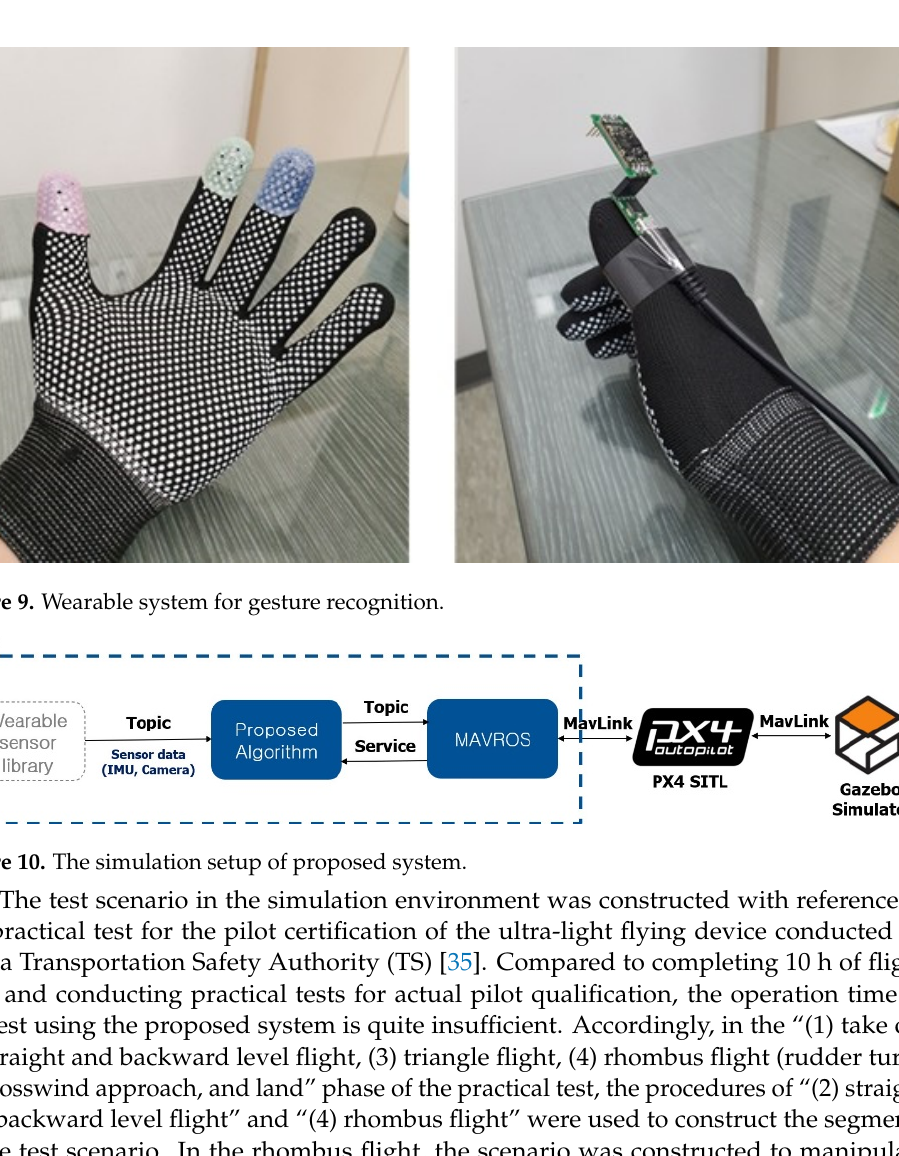
Figure 10. The simulation setup of proposed system.